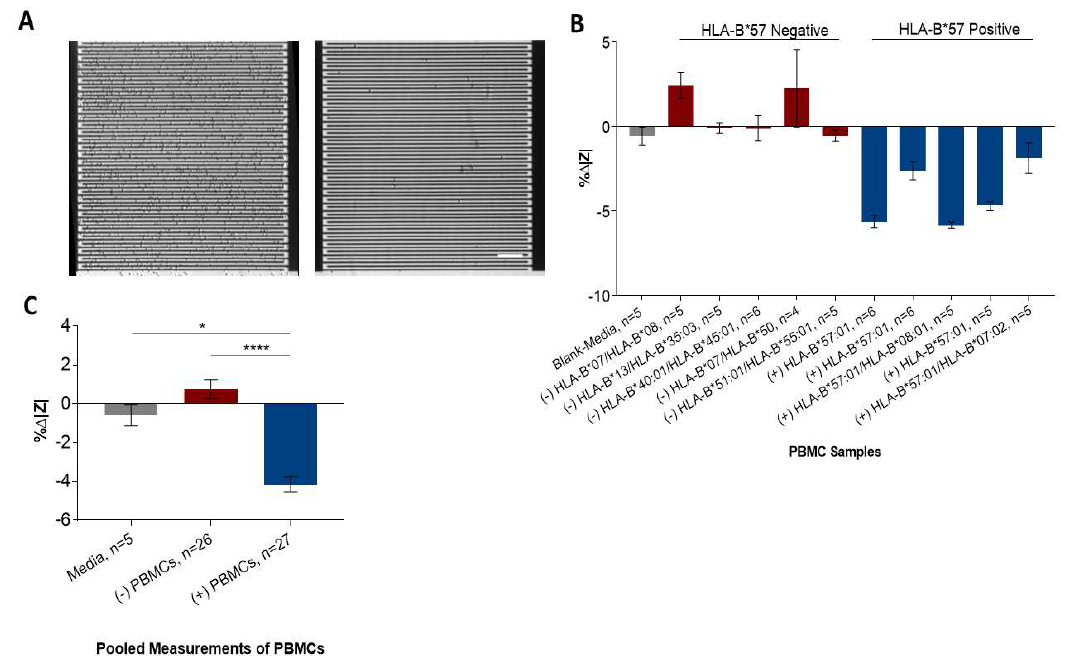
Figure 6. IDE sensors detecting sensors with captured HLA-B*57 expressing PBMCs. ( A ) Micrograph showing HLA-B*57:01 PBMC captured on dielectric sensors functionalized with a 3E12 antibody (left). Less cells were captured when non-HLA-B*57:01 were incubated on the sensor (right). ( B ) At applied frequency of 10 kHz, sensors showed significant impedance difference with sensors incubated HLA-B*57:01 PBMCs cells compared to non-HLA-B*57:01 PBMCs. ( C ) Sensor measurements were combined into groups of HLA-B*57:01 positive, HLA-B*57:01 negative, and media control incubated (mean ± SEM. Bar = 100 μm).